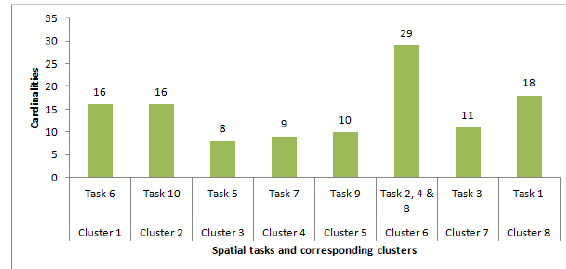
Figure 4: An OPTICS plot showing clustering structure